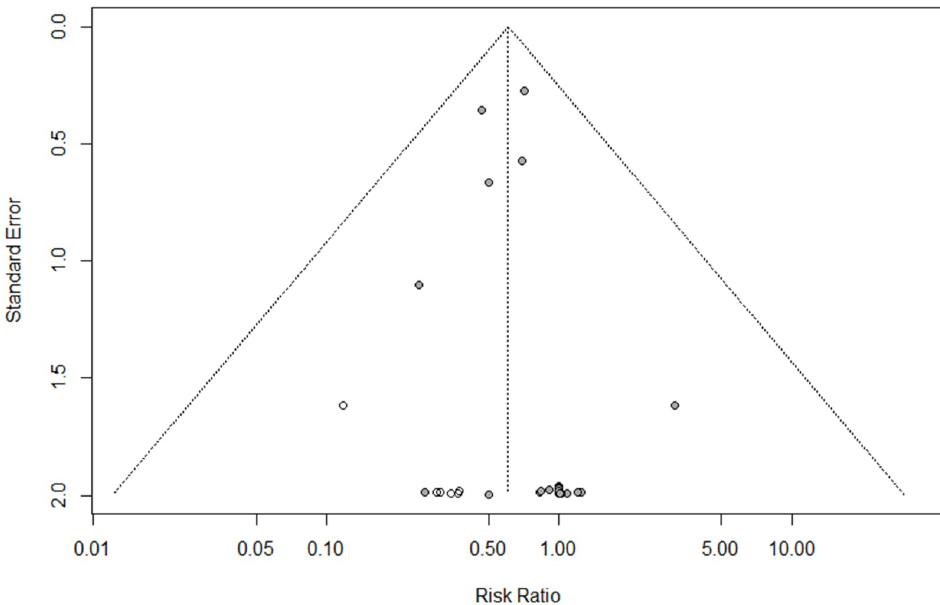
Fig 4. Funnel plot of combined outcome (cardiovascular mortality, myocardial infarction, stroke). Egger’s regression P = 0.039; trim and fill +9 studies. Filled circles represent studies included in the meta-analysis, open circles represent studies added during trim and fill